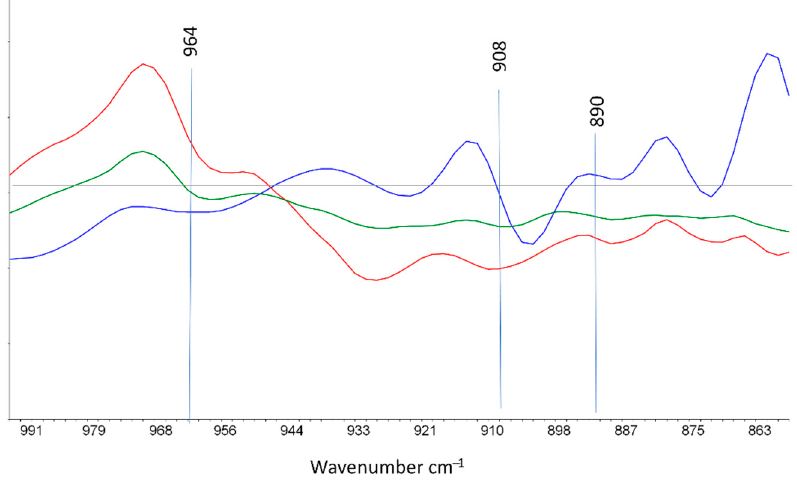
Figure 4. First derivative FTIR spectra in the range 995–860 cm − 1 of XLPE irradiated at 374 kGy and 40 Gy/h (red), XLPE irradiated at 336 kGy and 300 Gy/h (green), and non-irradiated XLPE (blue).